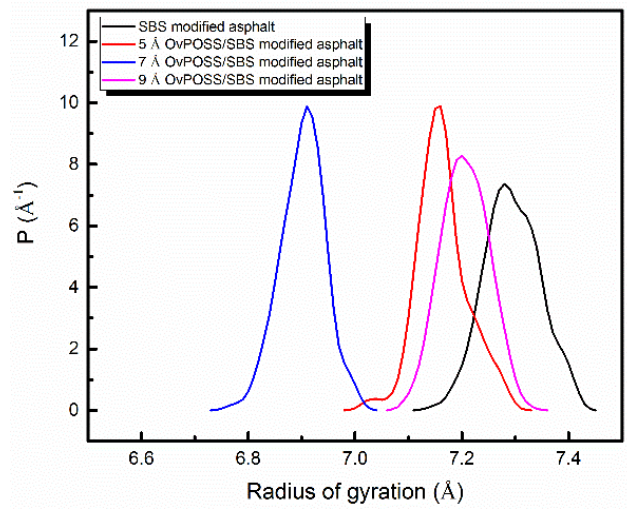
Figure 13. R g of SBS in different modified asphalt systems.